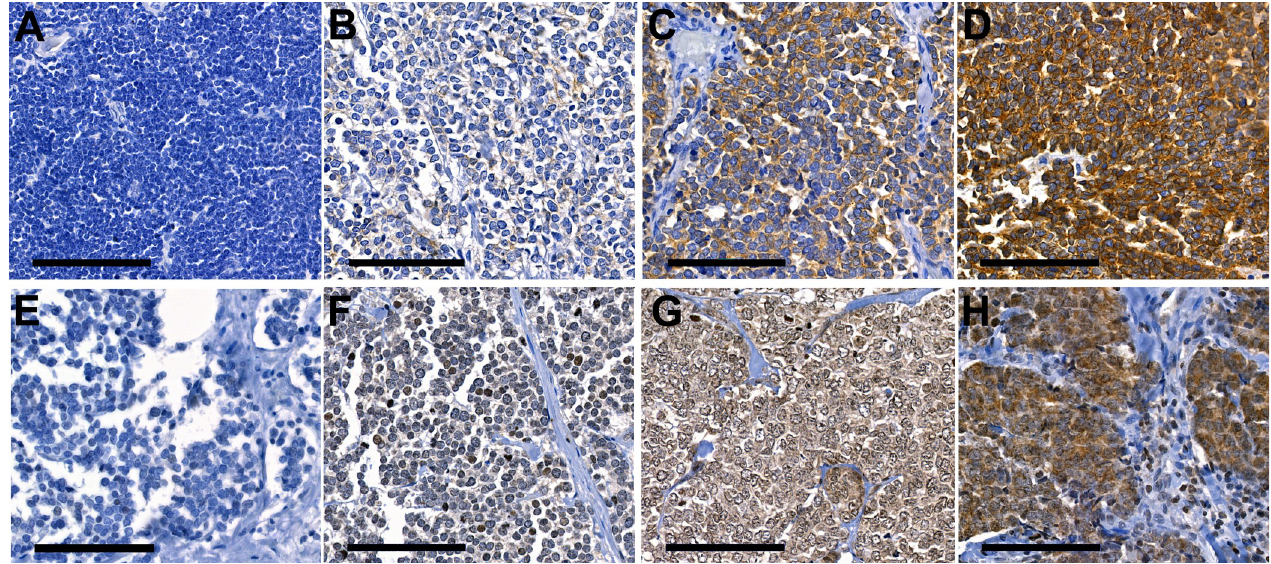
Fig 1. The grading of Immunohistochemistry staining as negative, low, intermediate or high is displayed for ALK (A to D) and p-ALK (E to H) across MCC TMA samples. 40x Magnification. Size bar 100 μ m.